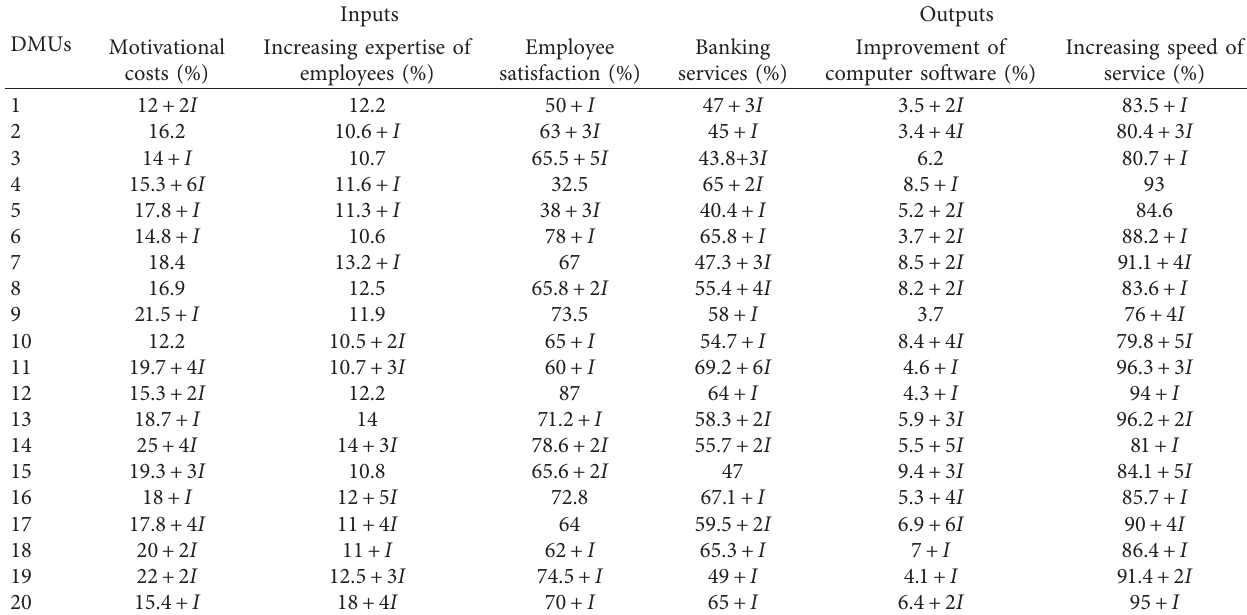
Table 1: Input and output of enablers.